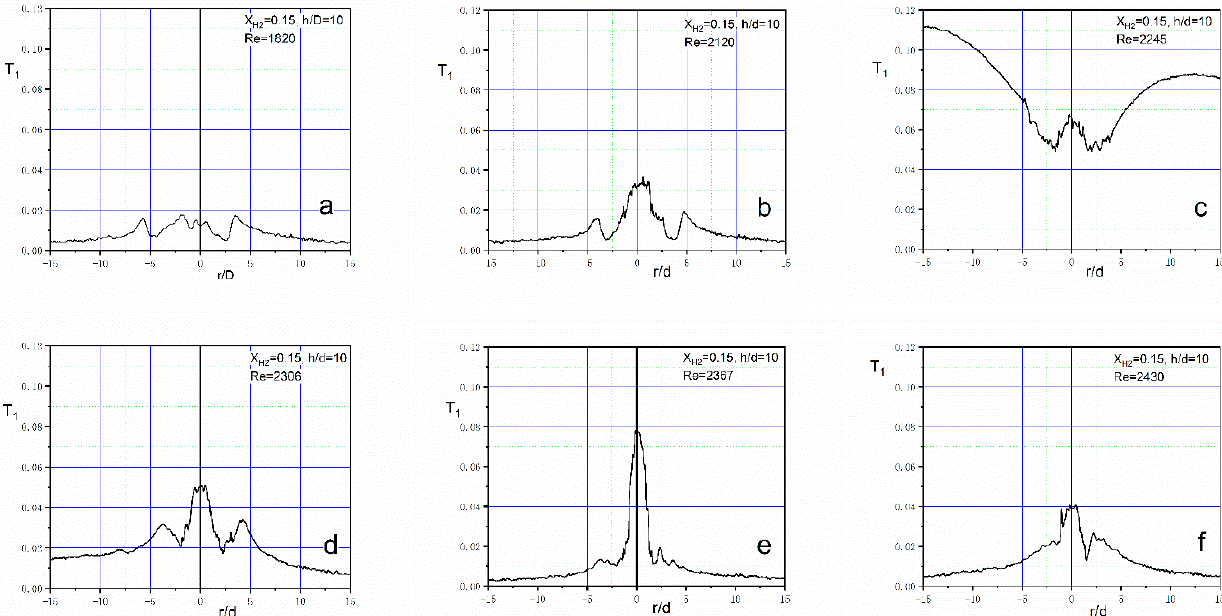
Figure 7. The intensity of temperature fluctuations during the flow of an impingement jet on the the catalytic surface ( d = 3 mm, h / d = 10, H 2 /N 2 , X H2 = 15%). ( a )— Re = 1820; ( b )— Re = 2120; ( c )— Re = 2245; ( d )— Re = 2306; ( e )— Re = 2387; ( f )— Re = 2430.